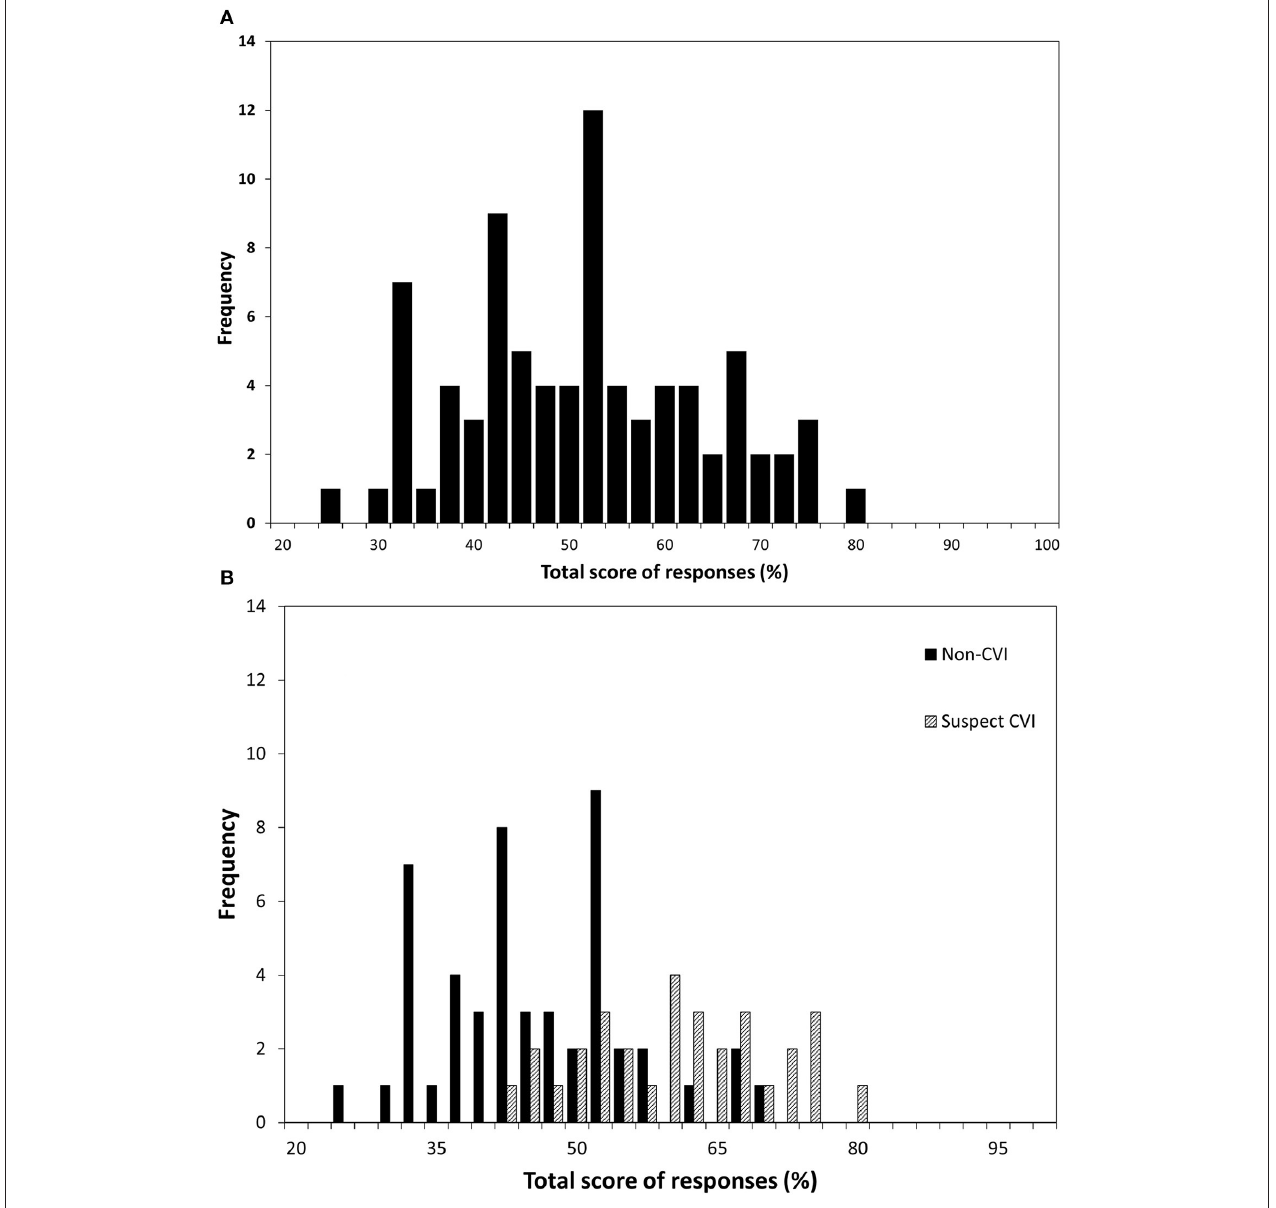
FIGURE 1 | The frequency distribution of the total raw scores in 81 children. The x-axis shows total score expressed as a percentage of applicable questions for (A) all children and (B) children divided into “suspected CVI” and “non-CVI” according to whether the child screened positive on the five-question CVI screening tool.